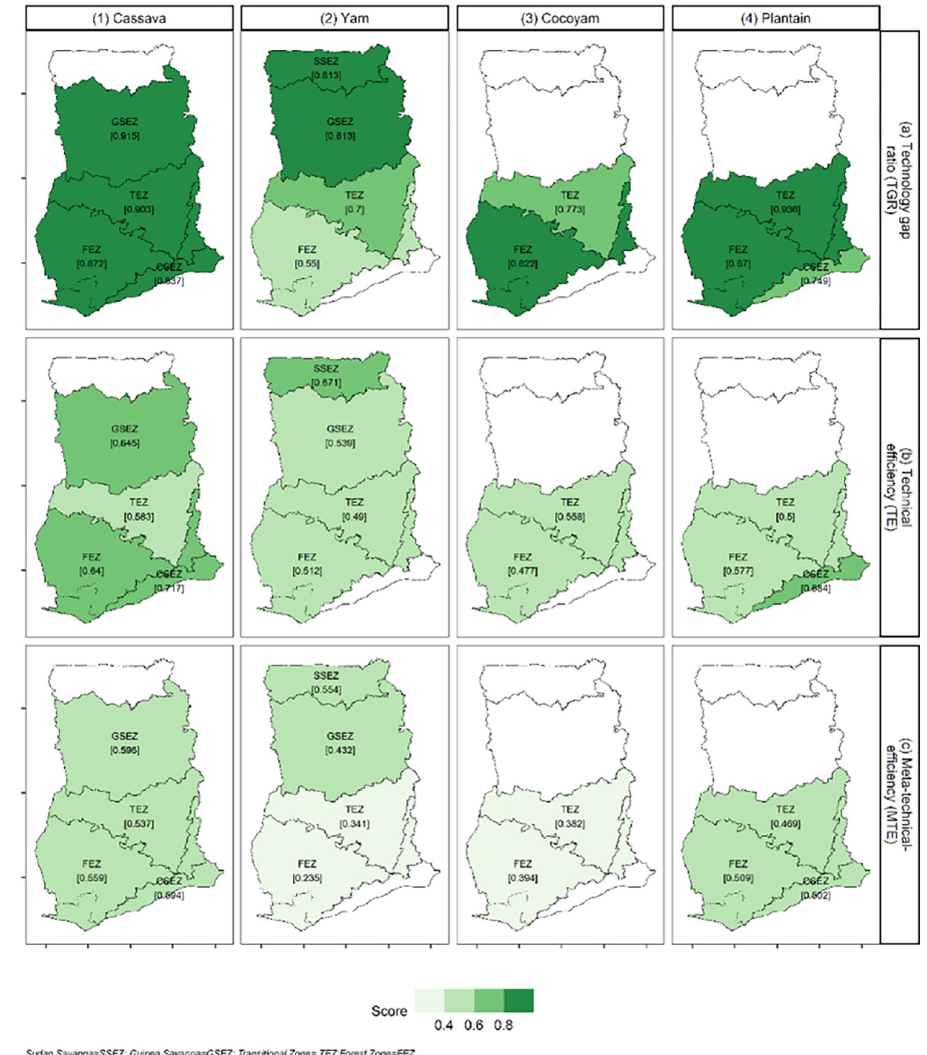
Fig 2. Ghanaian starchy staple production technology level and technical efficiency across ecologies (1987–2017). Notes: Farmer-level scores were estimated via a Meta − stochastic − frontier (MSF) analysis applied separately to 10 population − based surveys that represent 30 years of farmer-level data collection in Ghana the surveys used included Ghana Living Standards Surveys [wave 1 − 7] and Ghana Socioeconomic Panel Survey [wave 1 −